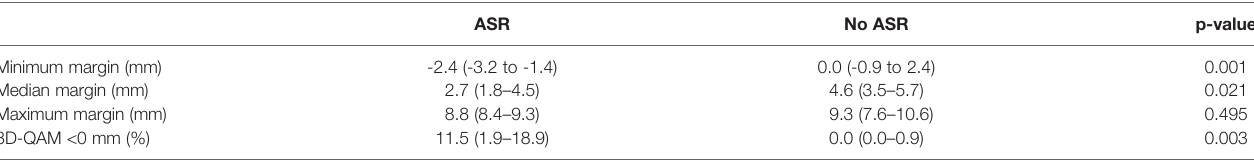
TABLE 2 | Numerical results of 3D-QAM assessment.